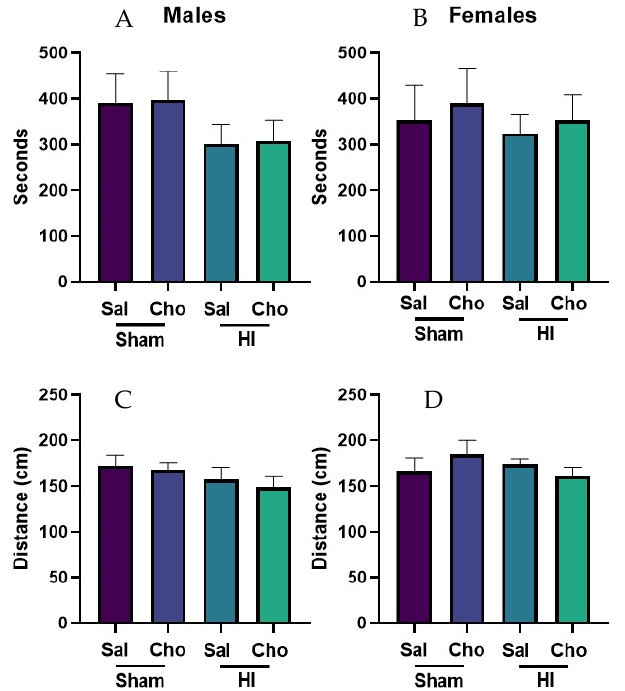
Figure 4. Motor performance was not significantly changed by hypoxia ischemia or choline in either sex. Neither HI nor choline administration significantly affected rotarod performance in males ( A ) or females ( B ). The total time spent on an accelerating rotarod was calculated. Data were collected across 3 days, with 3 trials per day. Dowel crossing performance was not significantly affected by HI or choline administration in male ( C ) or female ( D ) rats. The total distance traversed over 3 days consisting of 3 training trials each was calculated for analysis. Sham groups consisted of 6–7 rats per group; HI groups consisted of 8–11 rats per group. Sal = Saline; Cho = Choline; HI = hypoxia ischemia.